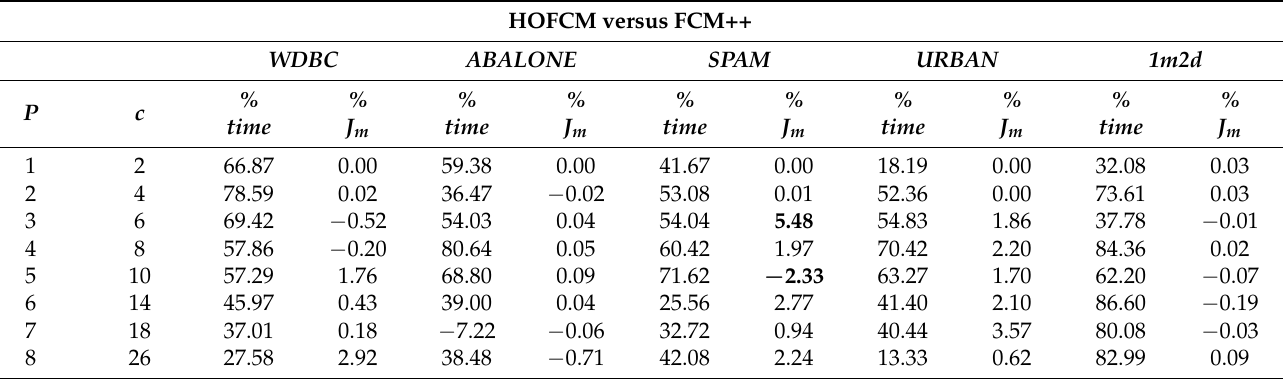
Table 3. Average percentages of time reduction and value of the objective function in Experiment II; HOFCM versus FCM++.